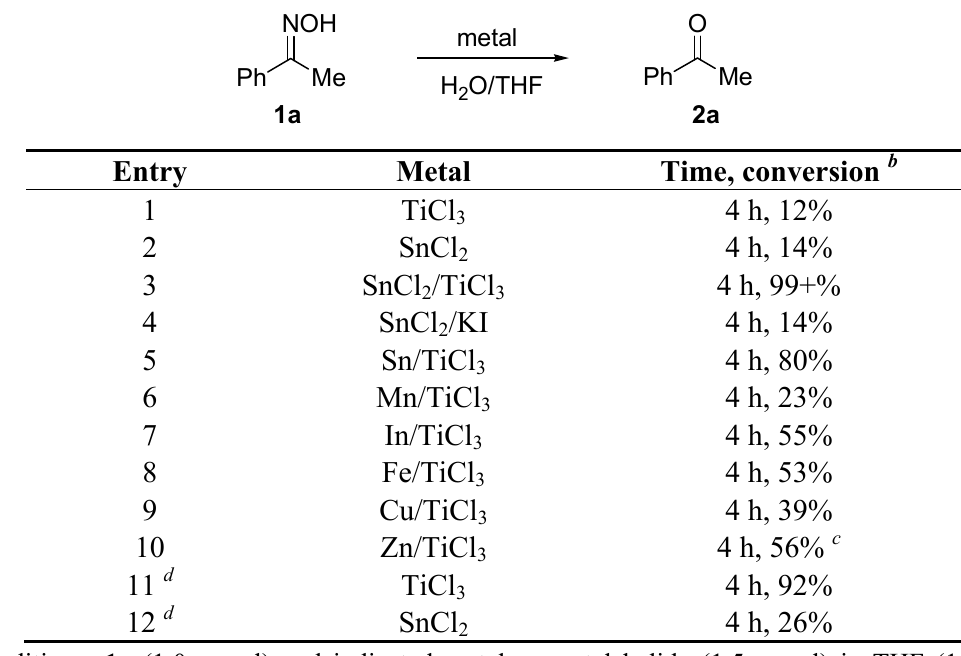
Table 1. Metal- or metal halide-mediated deoximation of ketoxime a